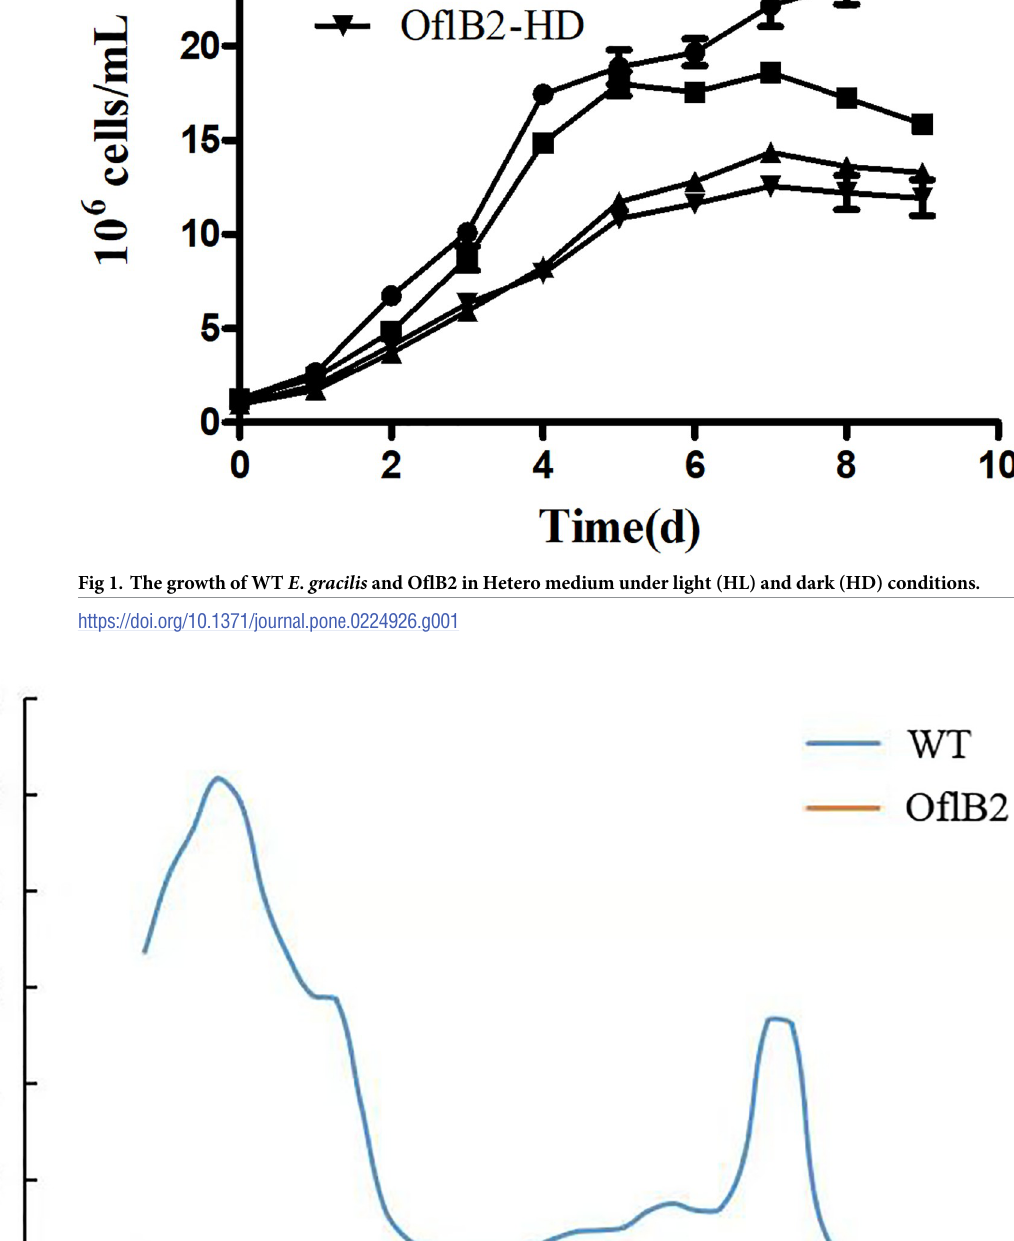
PLOS ONE | https://doi.org/10.1371/journal.pone.0224926 November7,